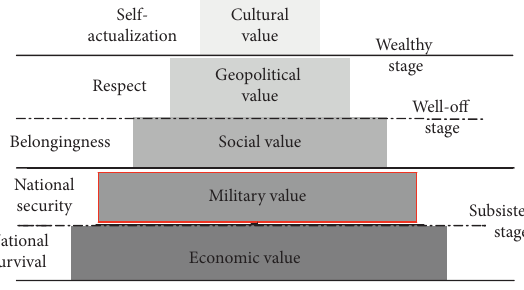
Figure 2: A hierarchical model of